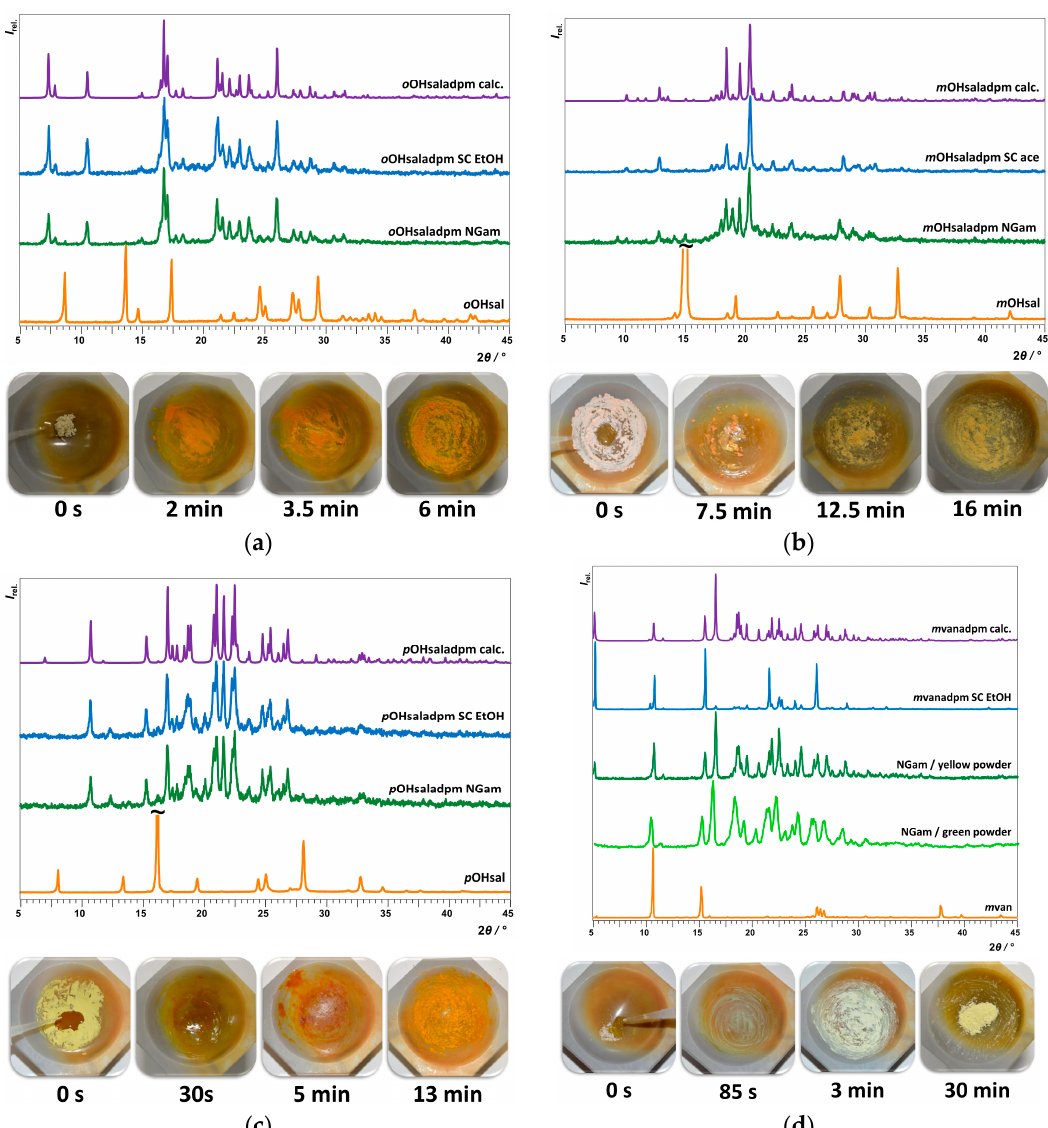
Figure 1. PXRD patterns of aldehydes and products of mechanochemical- and solution-based syntheses along with the calculated patterns (top) and photographs of the grinding experiments (bottom) for ( a ) oOHsaladpm ; ( b ) mOHsaladpm ; ( c ) pOHsaladpm and ( d ) mvanadpm .